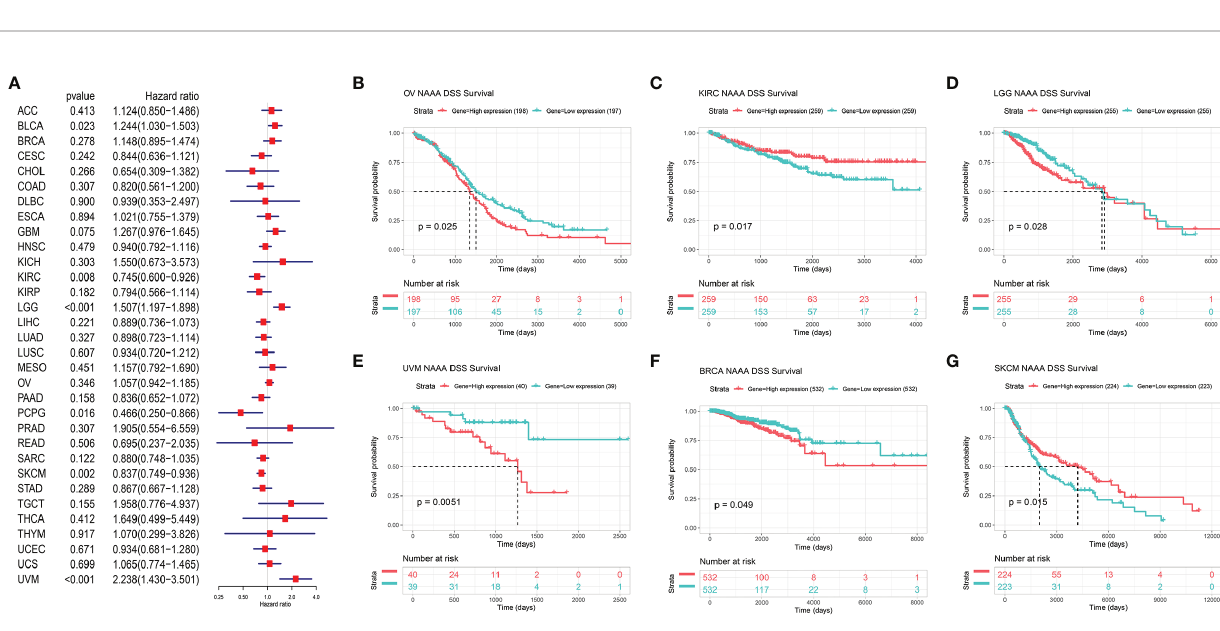
clear cell carcinoma, which show an alteration frequency of ~4% ( Figure 7A ). DNA methylation, as one of well-studied epigenetic